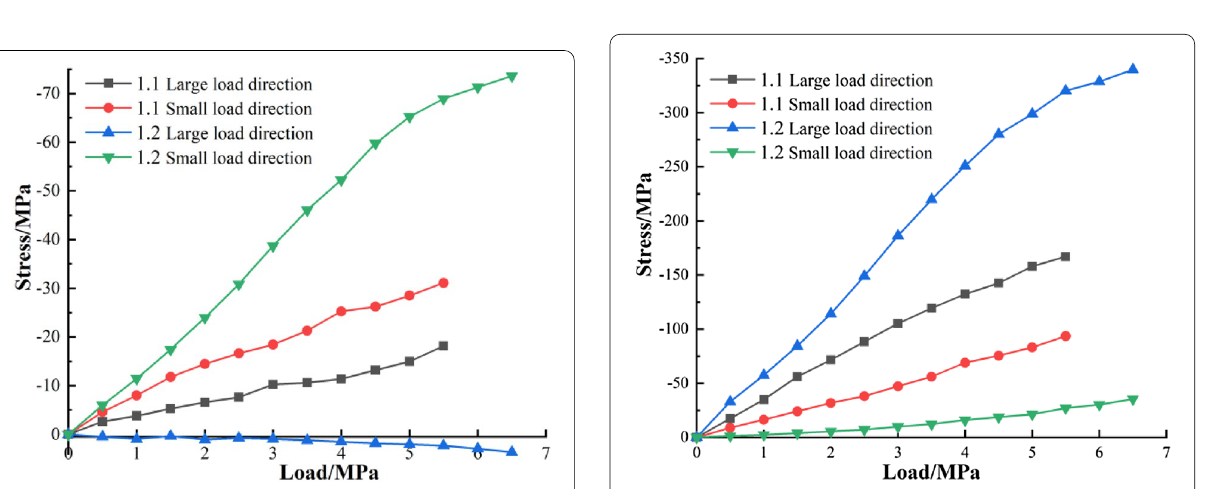
Fig. 16 Load–hoop stress relationship curve of outer